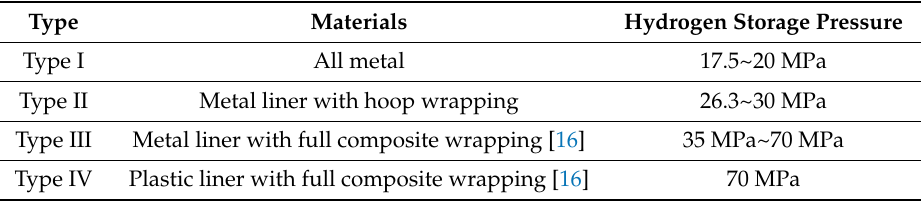
Table 1. Type of hydrogen storage